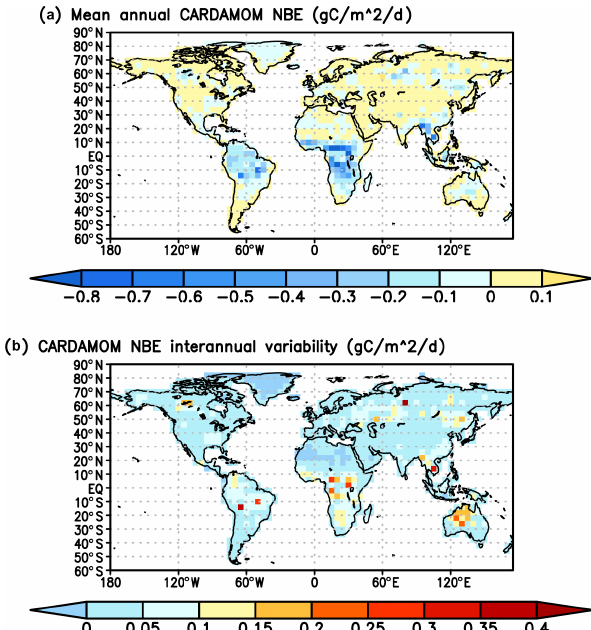
Figure B2. An example of absolute mean NBE (a) and its uncertainty (b) simulated by CARDAMOM. This is for July 2010.